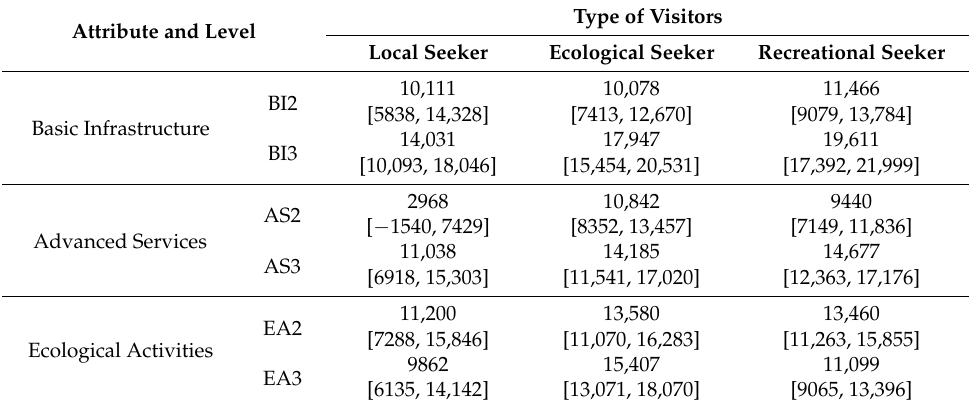
Table 8. The comparison of MWTP by type of